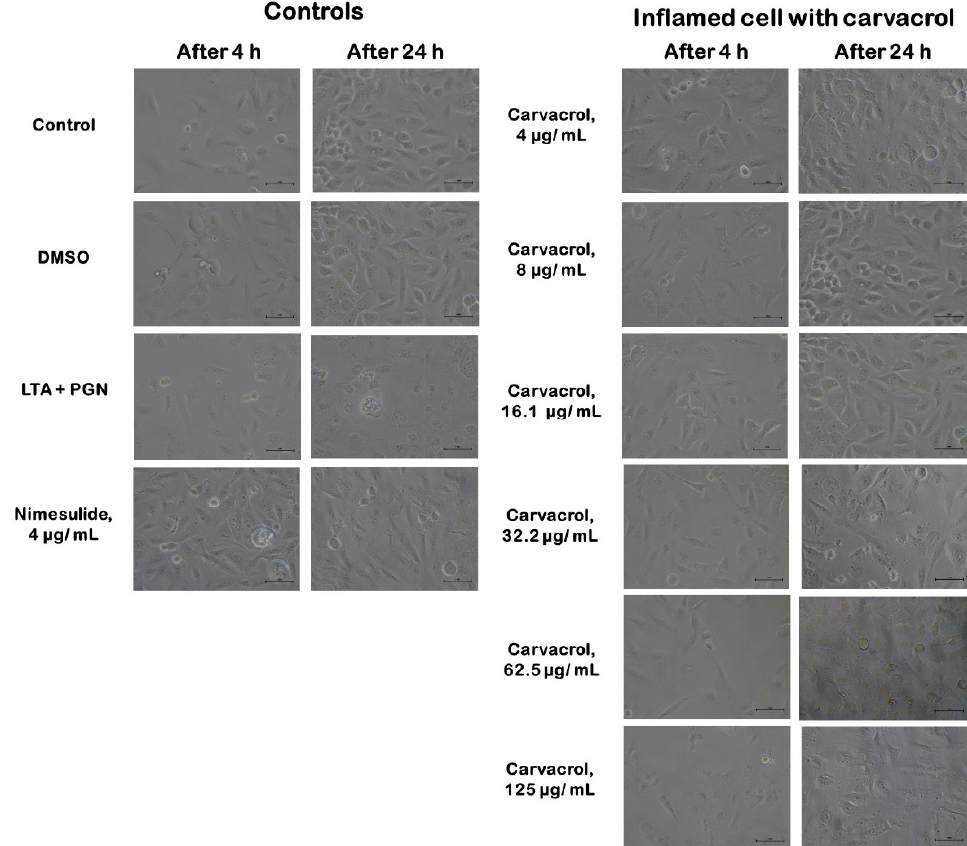
Figure 4. Morphology of human tonsil epithelial cells treated with carvacrol. Controls include cells of untreated growth medium control, DMSO control, LTA + PGN control, and nimesulide (4 µ g/mL). LTA+PGN-induced cells (4 h) were treated with carvacrol (4–125 μ g/mL) and incubated for an additional 20 hr. All images were obtained at a magnification of 10 × 40: scale bar = 1 μ m. LTA: lipoteichoic acid; PGN: peptidoglycan; ELISA: enzyme-linked immunosorbent assay.